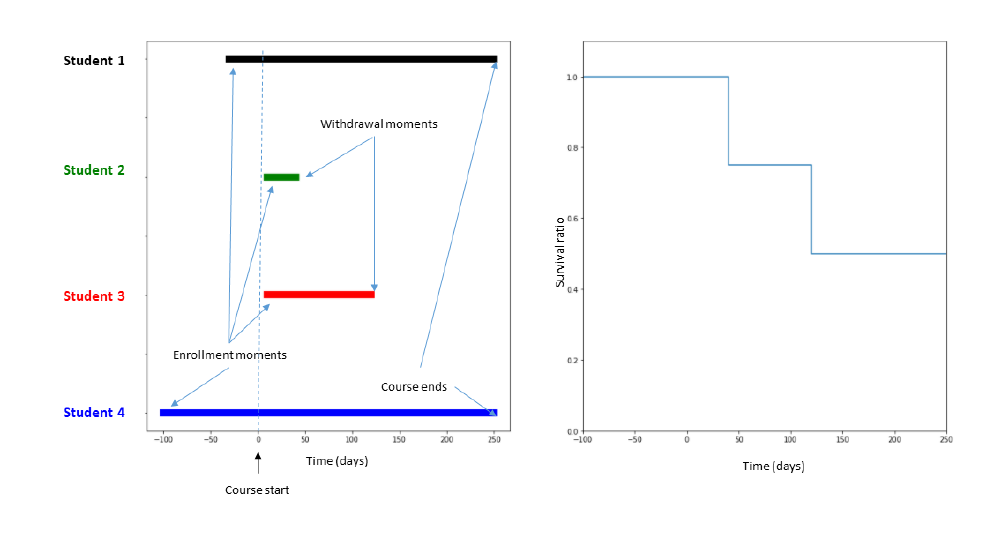
Graphical View of a Hypothetical Course and Associated Survival